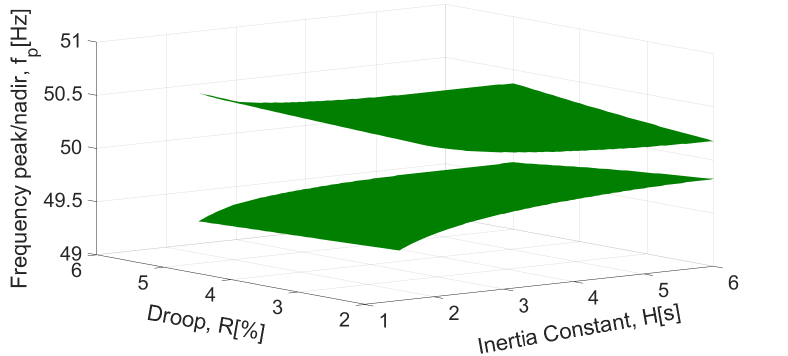
Figure 9. Impacts of R and H on f p for Wind Turbine.